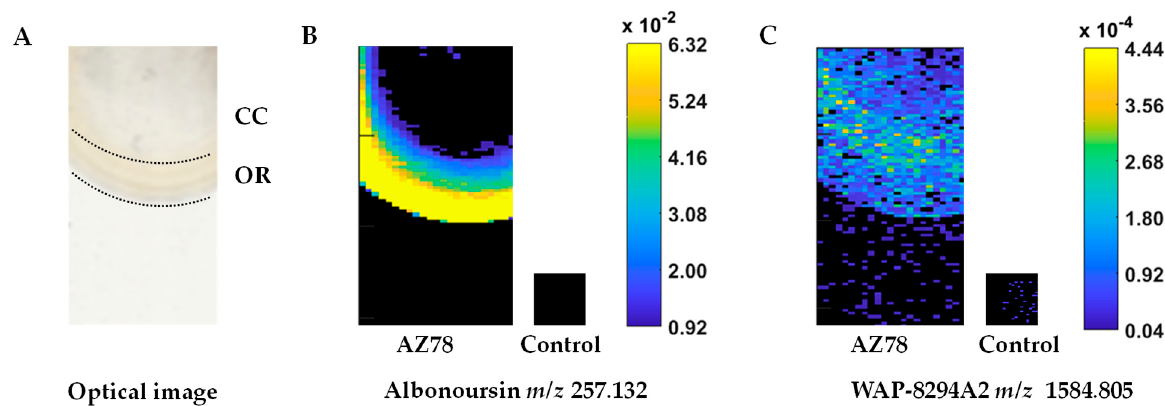
Figure 1. Mass spectrometric imaging of Lysobacter capsici AZ78 (AZ78) grown on Luria–Bertani Agar 1:10. The AZ78 macrocolony was divided into two regions of interest: the central core of the macrocolony (CC) and the outer ring of the macrocolony (OR). The optical image of the AZ78 macrocolony grown on LBA 1:10 was acquired just before matrix application ( A ); MALDI-qTOF-MS images were recorded at a lateral resolution of 150 × 75 μ m and represent TIC (total ion count) normalised data corresponding to ( B ) m / z 257.132 assigned to the 2,5-diketopiperazine albonoursin and ( C ) m / z 1584.805 assigned to the cyclic lipodepsipeptide WAP-8294A2. The colour bar shows normalised intensity values (black = absent, yellow = highest intensity). Table 1. Initial list of antimicrobial candidate analytes created following Matrix-Assisted Laser Desorption/Ionisation- Orthogonal Time of Flight Mass Spectrometric Imaging (MALDI-qTOF-MSI) of the Lysobacter capsici AZ78 (AZ78) macro-